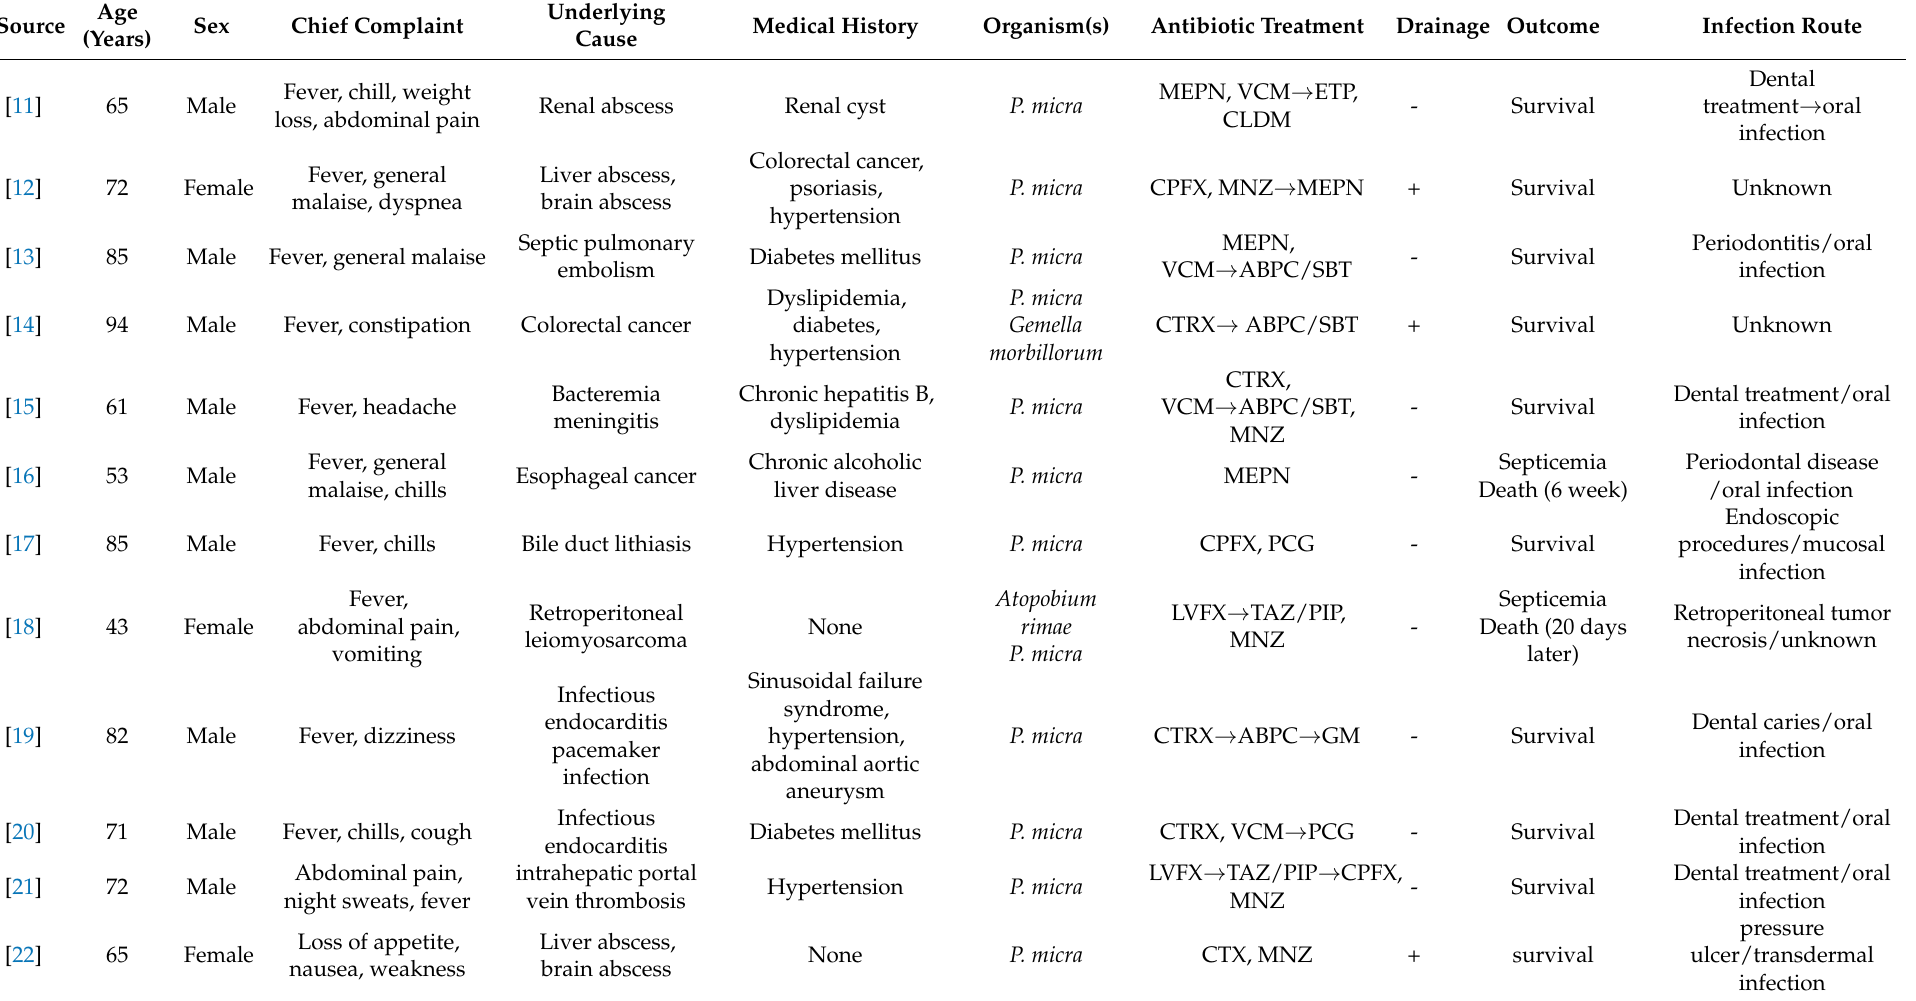
Table 2. Studies included in the